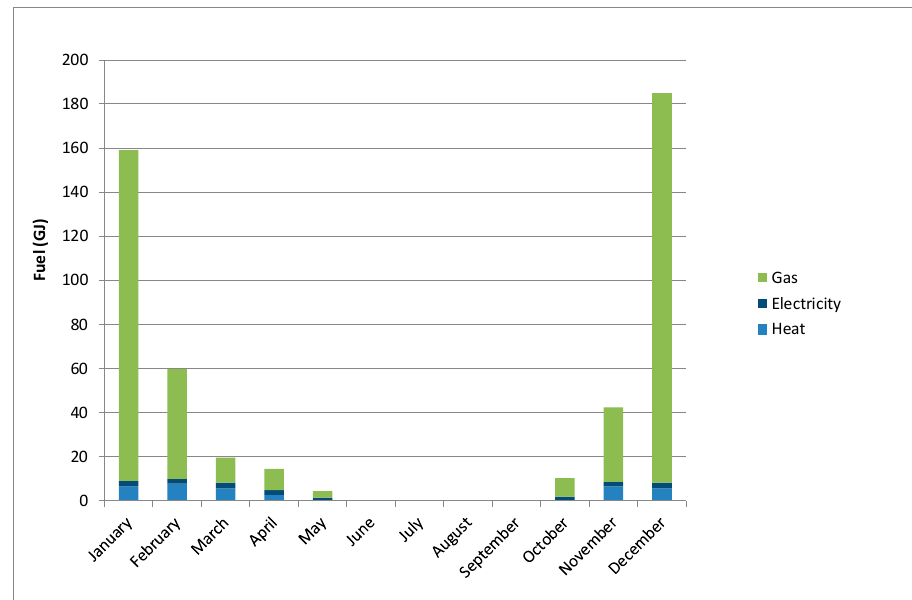
Figure 13. Gas boiler: Fuel.